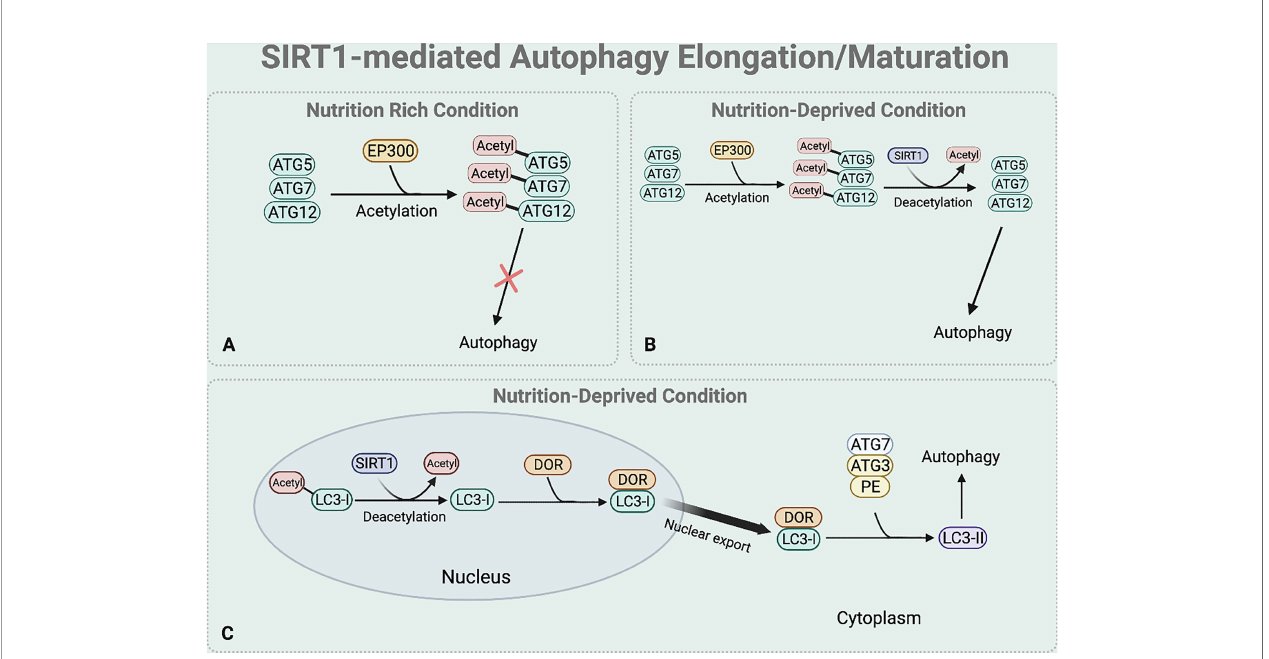
FIGURE 4 | SIRT1-mediated autophagy elongation and maturation regulation. The BNIP-3 expression then induces autophagy by using its functional BH3 domain to dissociate Beclin1 from the Bcl-2-Beclin1 complex. (A) Under nutrient rich condition, EP300 acetyltransferase inhibits the elongation of the autophagosome by acetylating the ATG5, 7, and 12. (B) Under nutrient deprived state, SIRT1 directly deacetylates these ATGs to form ATG 16-5-12 complex that aids in the elongation of the autophagic vesicle. (C) Under starved condition, SIRT1 directly deacetylates the nuclear LC3-I. The deacetylated LC3-I then interacts with DOR protein and this interaction between the deacetylated LC3-I and DOR protein allows the nuclear export of LC3-I. The deacetylation of LC3-I also helps LC3-I to interact with ATG7. Through this interaction, the translocated LC3-I conjugates to PE, forming LC3-II which is inserted to the autophagosome membrane to help selective targeting of the